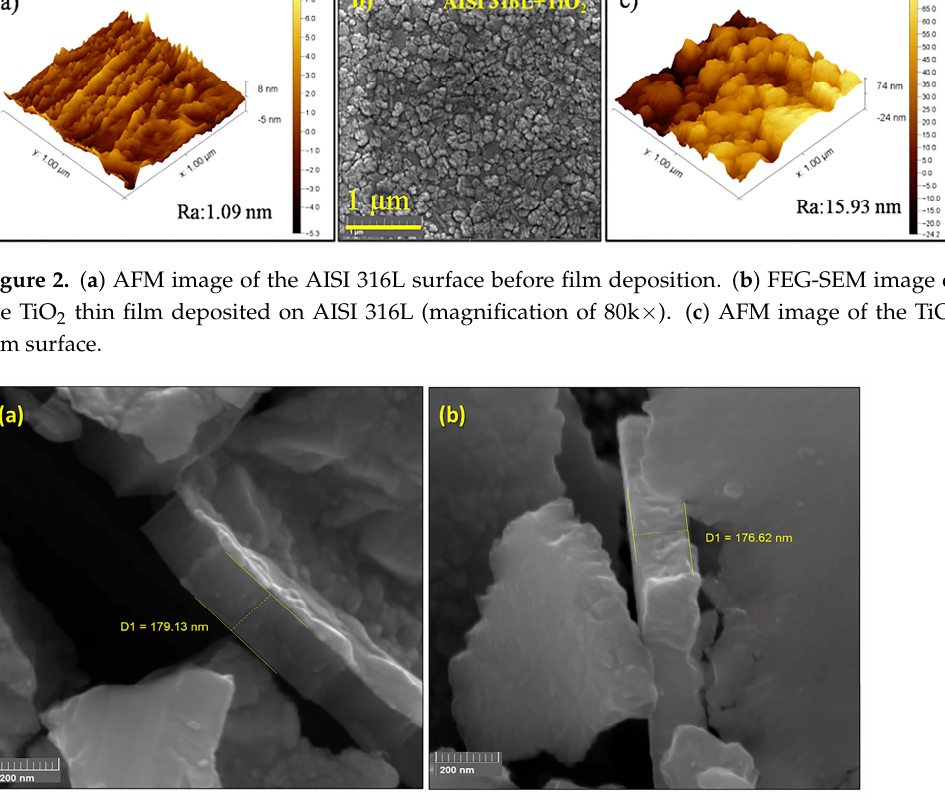
Figure 3. FEG-SEM images (200 kx magnification) of TiO 2 films deposited on ( a ) AISI 304 (179.1 nm film thickness) and ( b ) AISI 316L (176.6 nm film thickness).